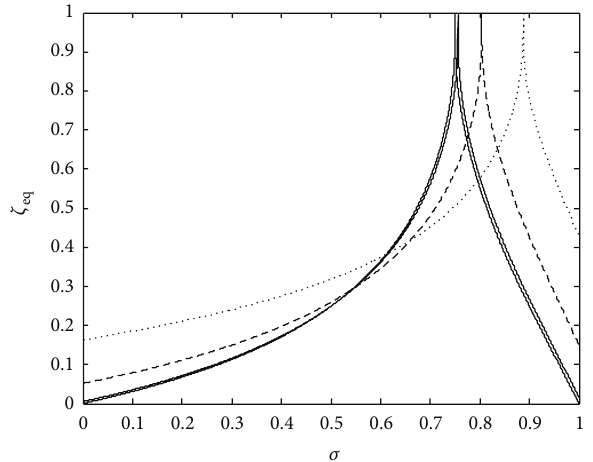
Figure 12: Equivalent damping ratio 𝜁 considering viscous damping in both primary and secondary sys- tems, considering the same damping ratio in both systems, so 𝜁 = = 𝜁 𝜁 1 2 . The frequency ratio is 0.1; - - - 𝜁 =